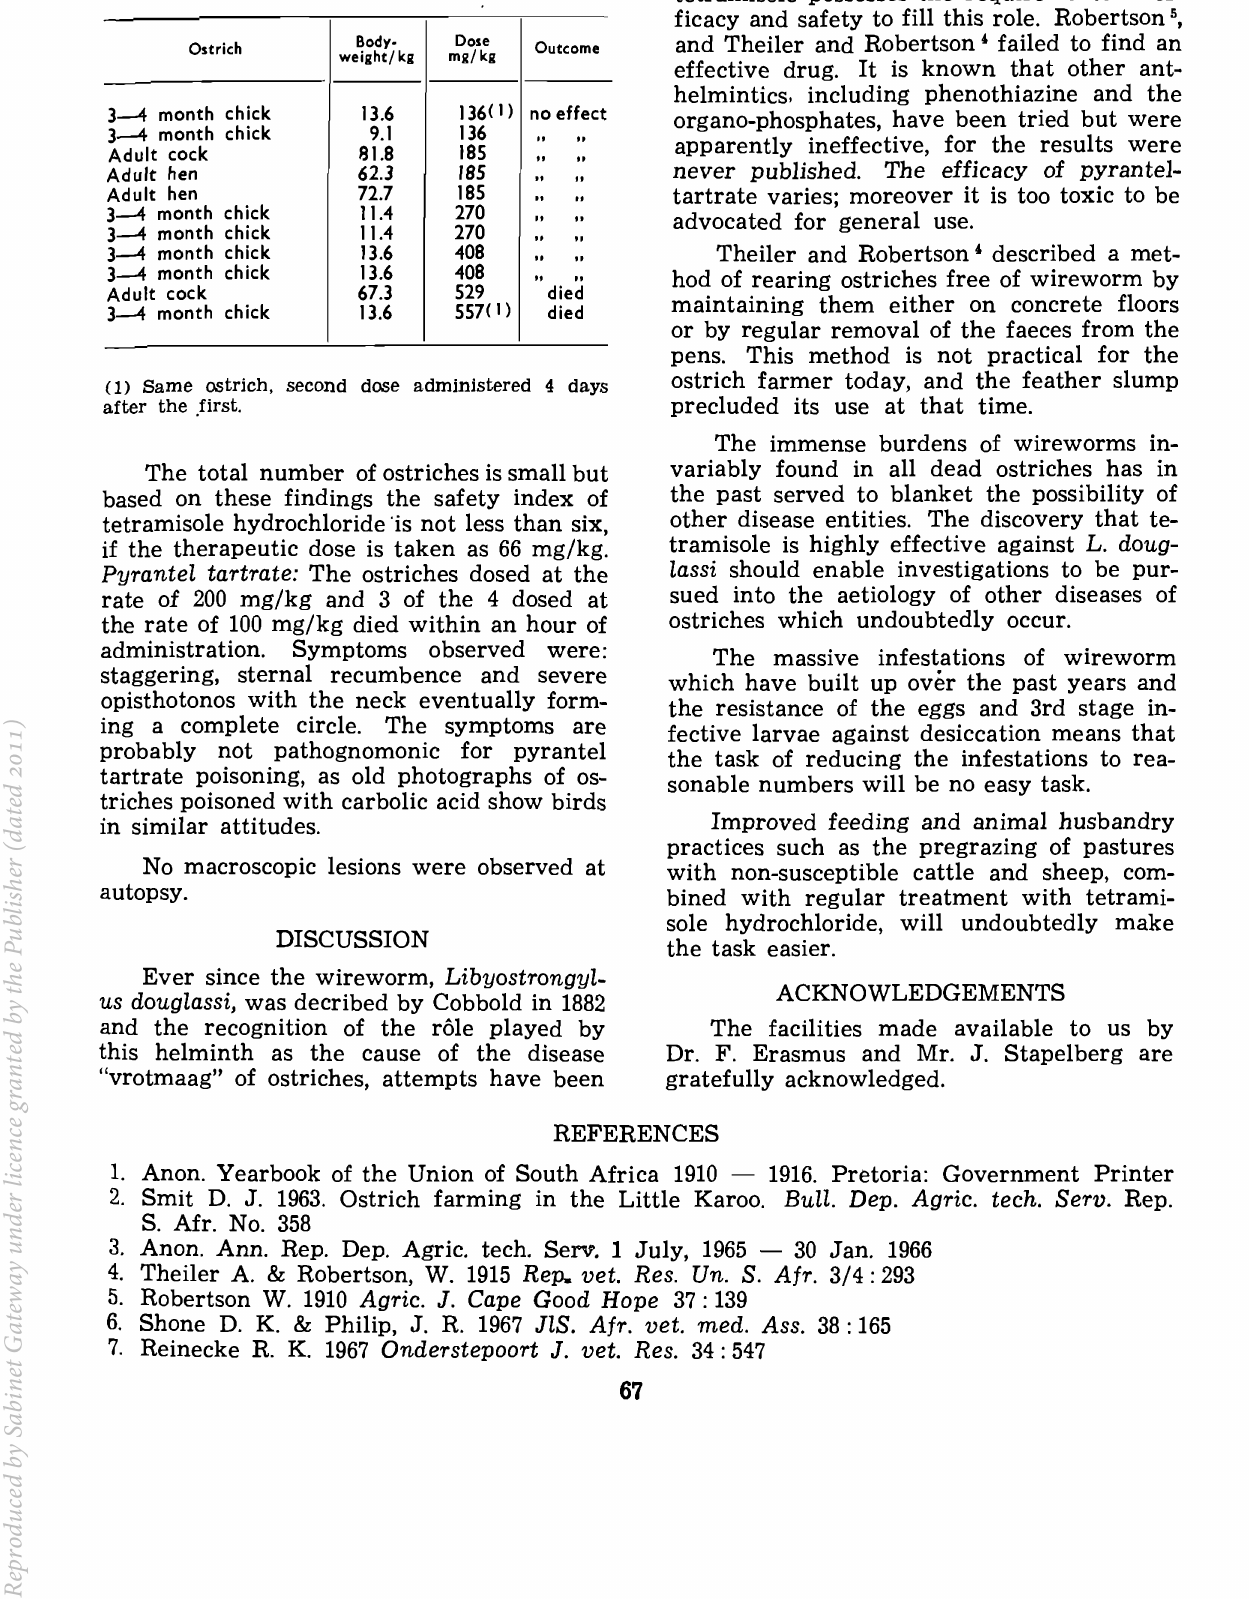
Table 3: TOXICITY STUDIES ON OSTRICHES DOSED WITH TETRAMISOLE HYDROCHLORIDE